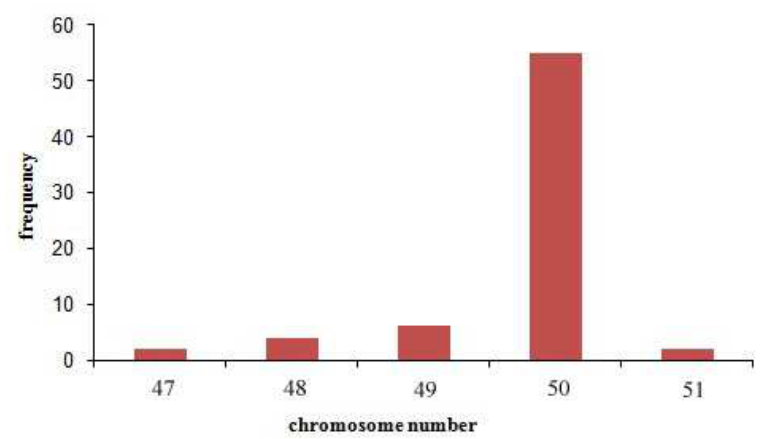
F IGURE 2. Distribution of the chromosome numbers from 69 metaphase plates from